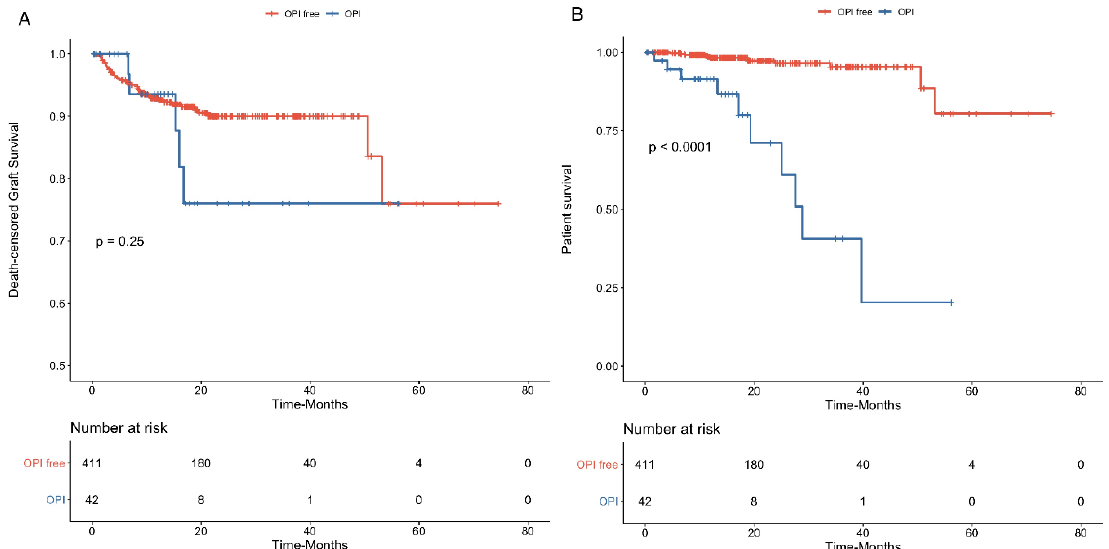
Figure 3. Outcomes of opportunistic infections (OPI) on graft loss and patient survival. Kaplan–Meier analysis curve, showing death-censored graft survival (Panel A ) and patient survival (Panel B ) rates regarding the occurrence of OPIs ( N = 42) or no OPIs ( N = 411). OPIs were significantly associated with worse patient survival but did not impact on death-censored graft loss.